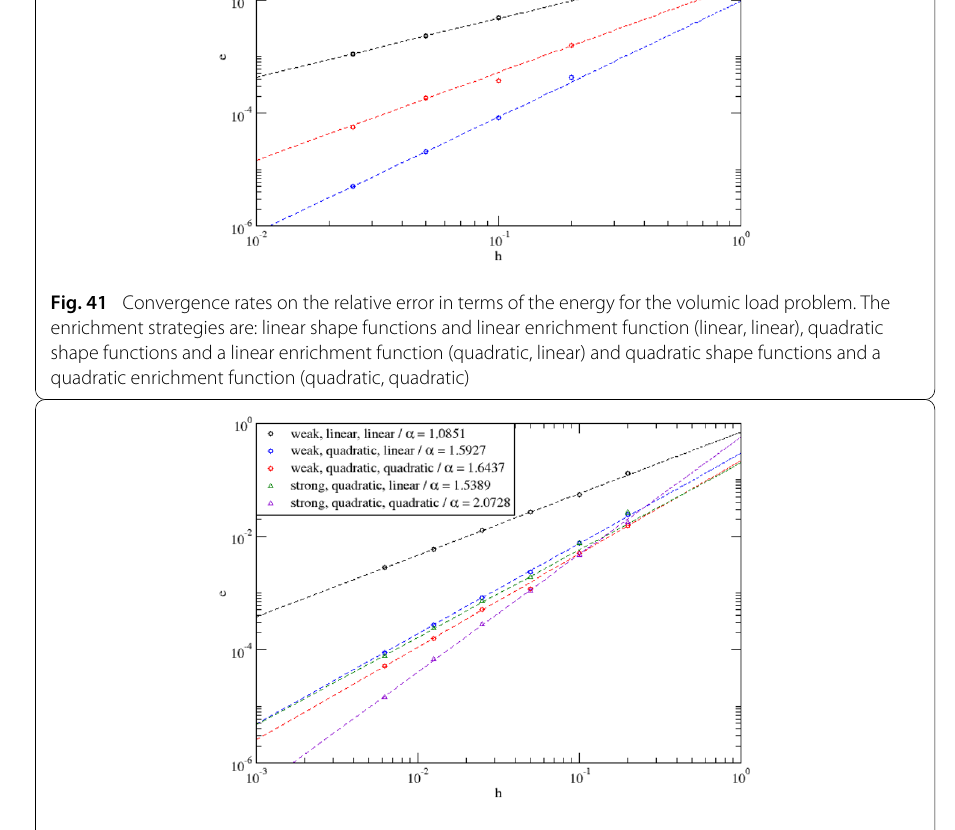
Fig. 42 Convergence rates on the relative errors with respect to mesh refinement for the circular inclusion problem. The enrichment strategies are: linear shape functions and linear enrichment function (weak, linear, linear), quadratic shape functions and linear enrichment (weak, quadratic, linear) and quadratic shape functions and quadratic enrichment function (weak, quadratic, quadratic). Two models based on the enrichment designed for strong discontinuities, using Lagrange multipliers to enforce the continuity of the displacement through the interface have also been investigated: one with quadratic shape functions and a linear approximation of the level set (strong, quadratic, linear) and one with quadratic shape functions and